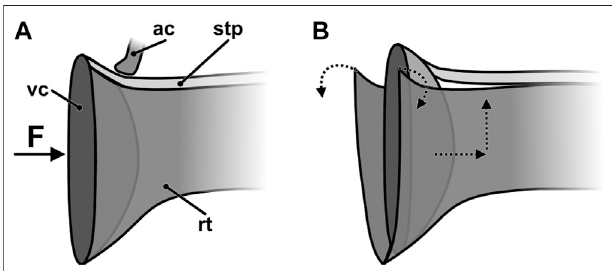
FIGURE 7 | Schematic drawing of the viscidium sitting in the rostellar pouch (A) before and (B) after applying a suf fi cient force, e.g., by a pollinator. The dotted arrows indicate direction of movement and of deformation. ac, anther cap (only the lip is shown); F, load; rt, rostellum; stp, stipe; vs, viscidium.